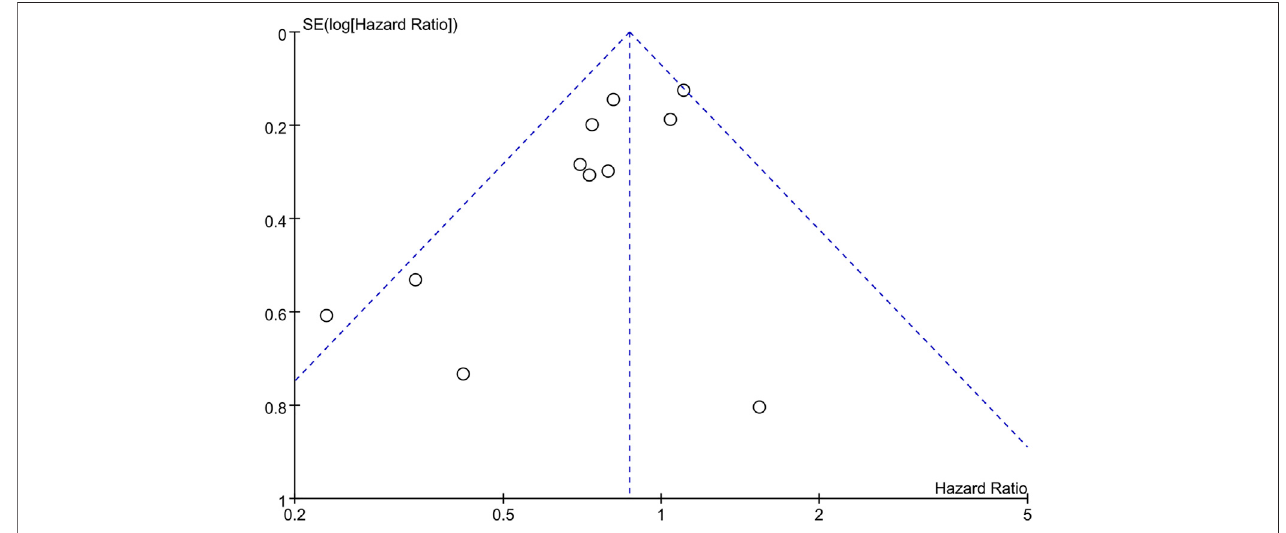
FIGURE 3 | The funnel plot for overall